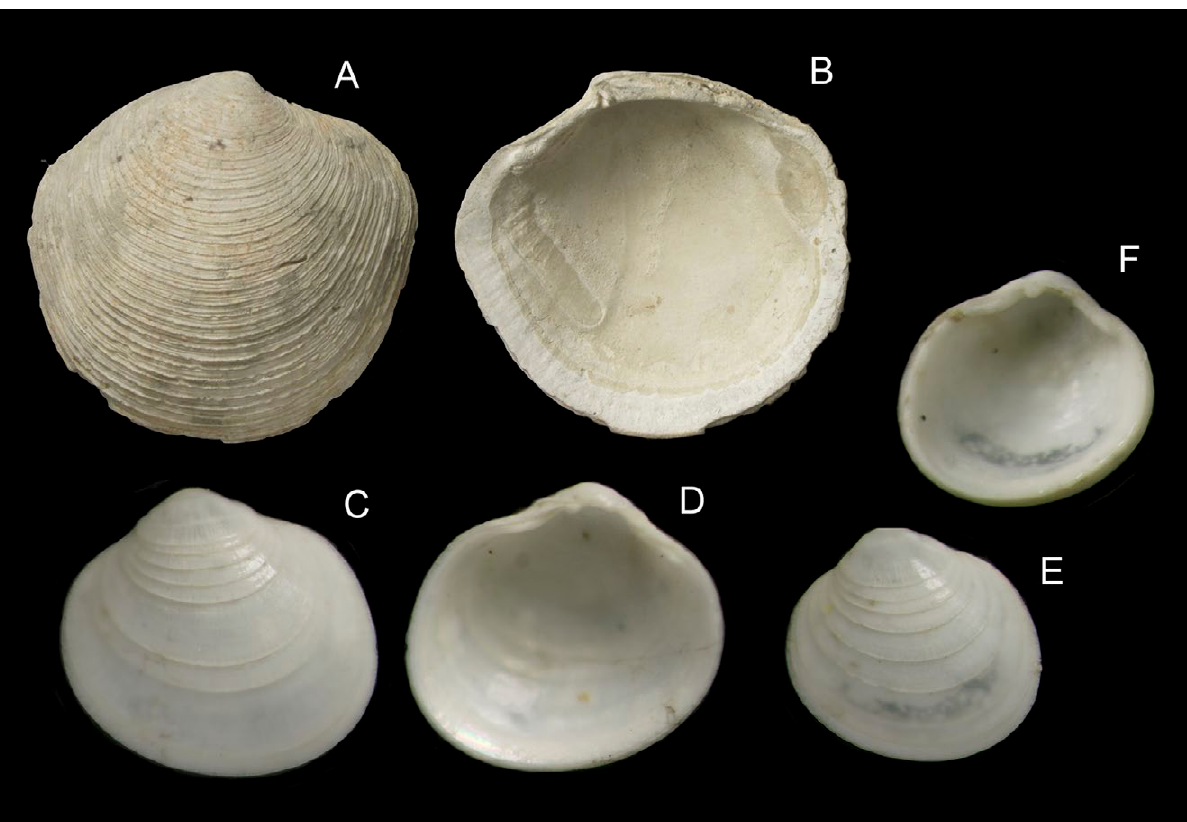
Fig. 5. – A-B, Lucinoma asapheus P. G. Oliver, Rodrigues and Cunha, 2011, INDEMARES/CHICA 0610 BC6.3, 369 m depth (37.0 mm); C-D, Draculamya porobranchiata P.G. Oliver and Lützen, 2011, INDEMARES/CHICA 0610 BC8.3, 427 m (1.2 mm); E-F, D. porobranchiata, BC8.3 (1.0 mm). BC,